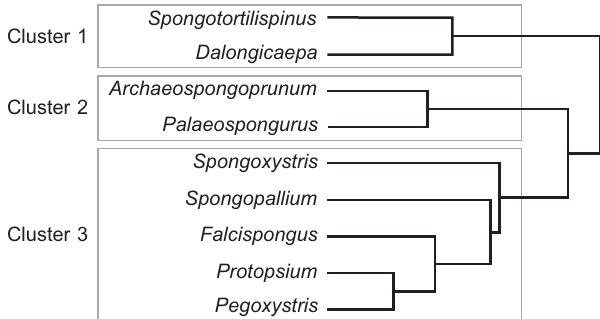
Fig. 4. Dendrogram of the cluster analysis under the corresponding analy- sis based on nine genera (performed by software “R” and the EZR